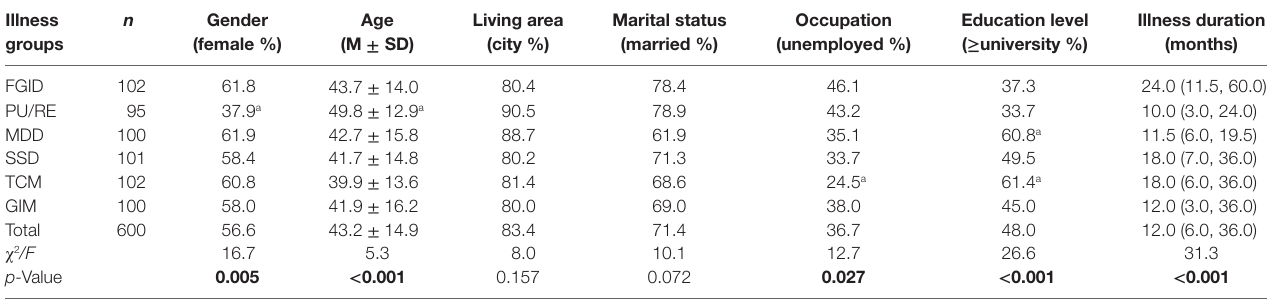
Table 1 | Sociodemographic and clinical characteristics of six illness groups of participants ( n = 600). illness